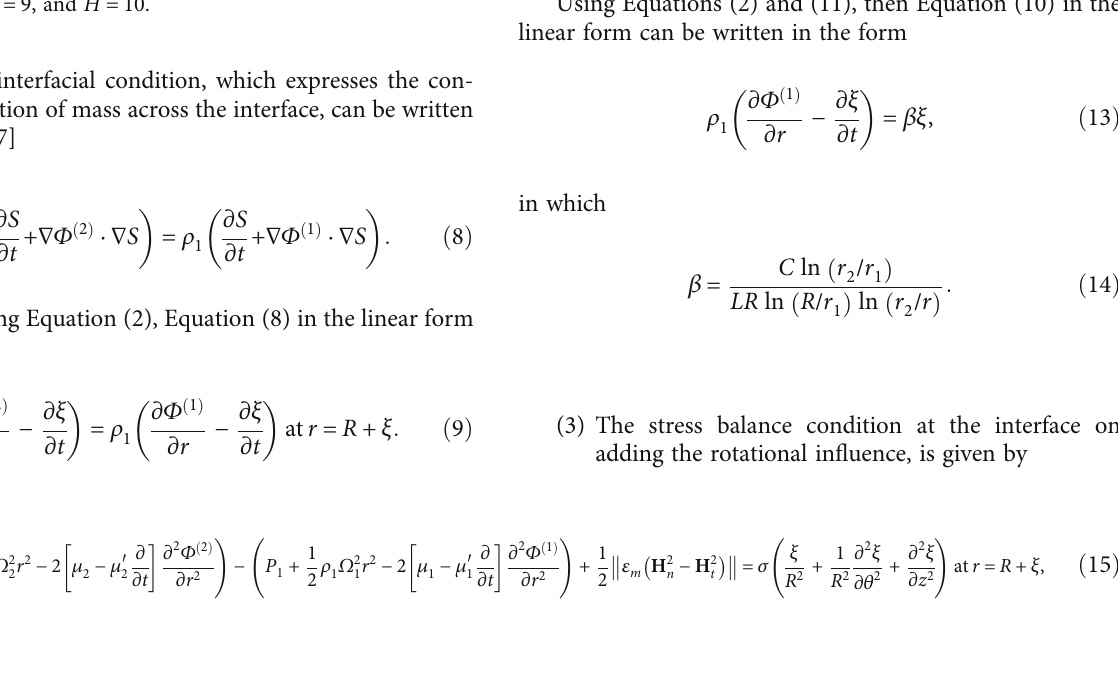
2 on growth rate b β = 0 : 3 , b ε m = 0 : 2 ,